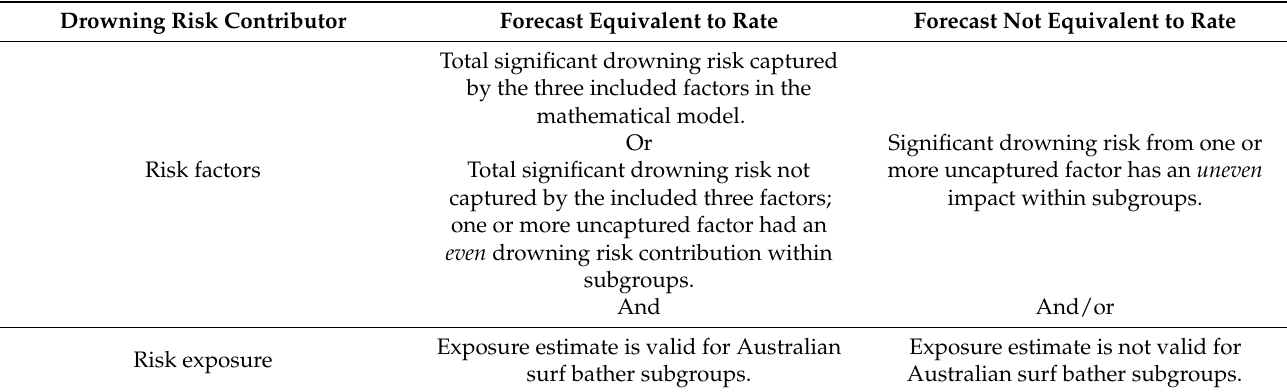
Table 6. Speculative explanations for comparisons between drowning forecast and drowning rate based on risk markers. Drowning Risk Contributor Forecast Equivalent to Rate Forecast Not Equivalent to Rate Total significant drowning risk captured by the three included factors in the mathematical model. Significant drowning risk from one or Or more uncaptured factor has an uneven Total significant drowning risk not Risk factors impact within subgroups. captured by the included three factors; one or more uncaptured factor had an even drowning risk contribution within subgroups. And And/or Exposure estimate is valid for Australian Exposure estimate is not valid for Risk exposure surf bather subgroups. Australian surf bather